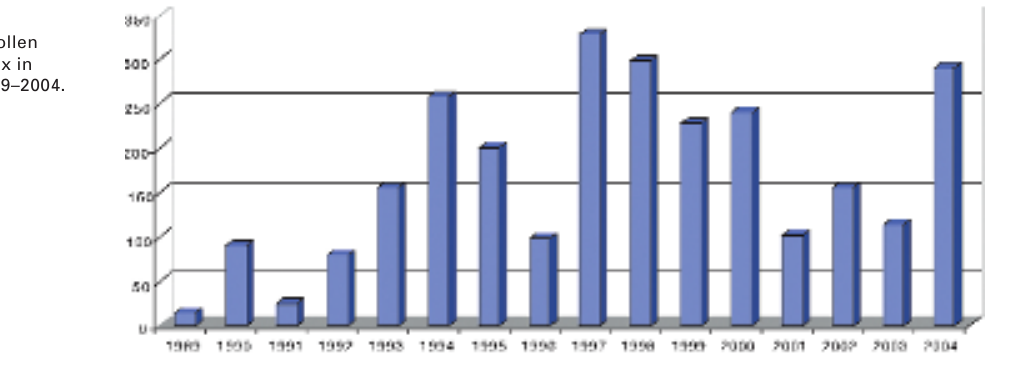
(Modified from Mau- rer 2003 [57]) Two- hours concentration of ragweed pollen recorded by the pollen traps located in the centre of the city (HUG) and in the surrounding of an infested field near Geneva (Bernex): episode showing long-range trans- ported pollen regis- tered in the evening on 3 rd September and local pollen peak on 4 th September in the